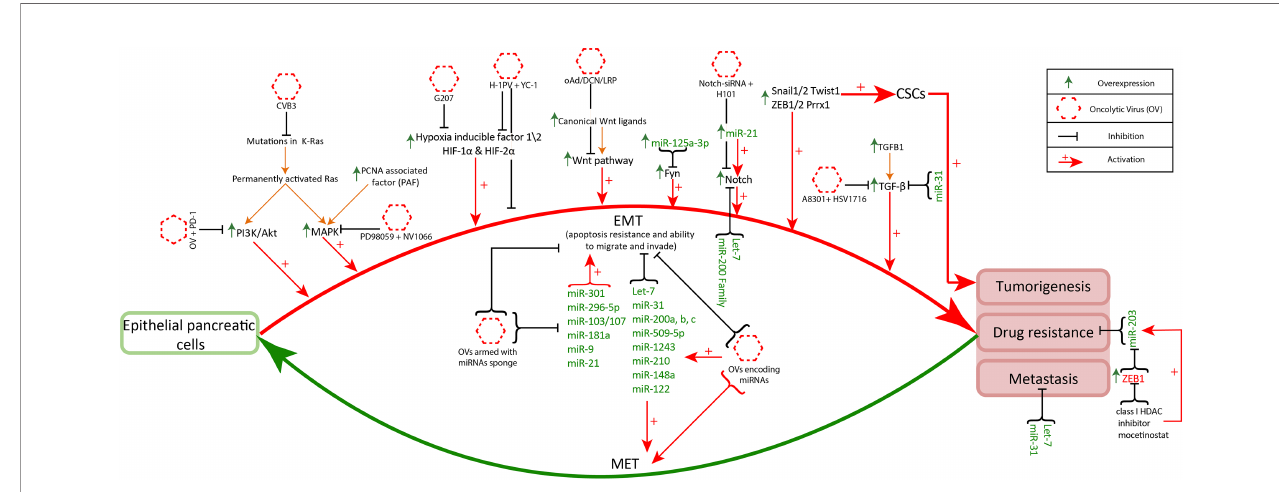
FIGURE 2 | Disrupted pathways targeting with oncolytic viruses: Disruptions in K-Ras, hypoxia, Notch signaling, MAPK, PI3K/Akt and TGF- b signaling pathways facilitates increased anticancer speci fi city of oncolytic viruses. CVB3 and reovirus effectively infect cancer cells with mutant K-Ras (111). The administration of oncolytic viruses along with PD-1 in PI3k/Akt upregulated cancer cells can exhibit increased antitumor immune memory (112). Likewise, oncolytic viruses administration along with the inhibitors of overexpressed genes (MAPK, Wnt, TGF- b , Notch1, HIF-1 a ) facilitates oncolytic virus infection and enhances its antitumor property (113 – 116). The multiple overexpressed miRNAs (miR-301, miR-296-5p, miR-103/107, miR-181a, miR-9, miR-21) promote EMT related signaling increasing invasiveness and chemoresistance of pancreatic cancer. Targeting these miRNAs with oncolytic viruses armed with miRNAs sponges helps in the reduction of cancer progression and increases antiviral activity (117). On the other hand miRNAs (Let-7, miR-31, miR-200 family, miR-509-5p, miR-1243, miR-210, miR-148a, miR-122) regulate normal functioning in the pancreas and inhibit EMT associated signaling. These miRNAs are underexpressed in pancreatic cancer and the oncolytic viruses encoding these miRNAs have better cancer cell speci fi city and anticancer response